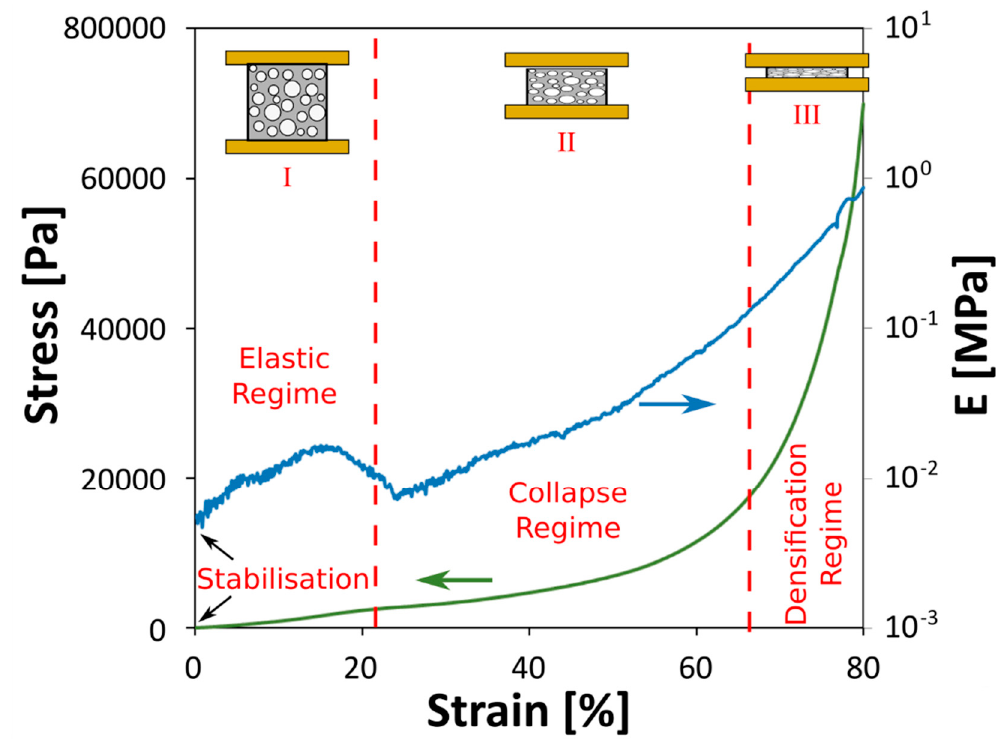
Figure 6. Stress–strain primary axis and modulus–strain secondary axis curves of a composite foam.